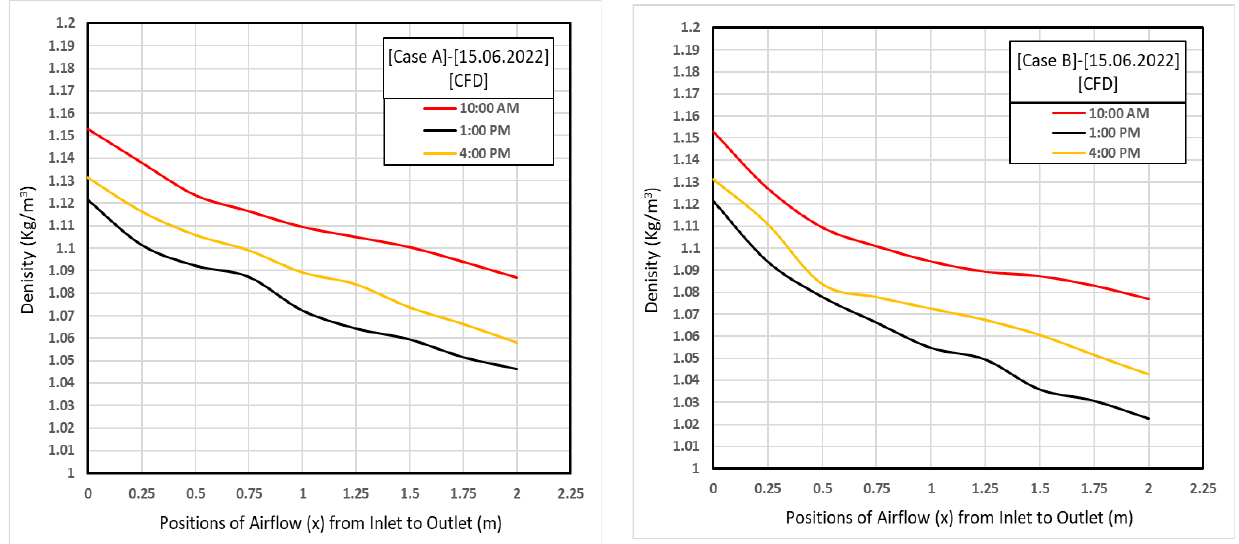
Figure 18. CFD airflow density results for the Case A and Case B FPSAHs tested at various time intervals.